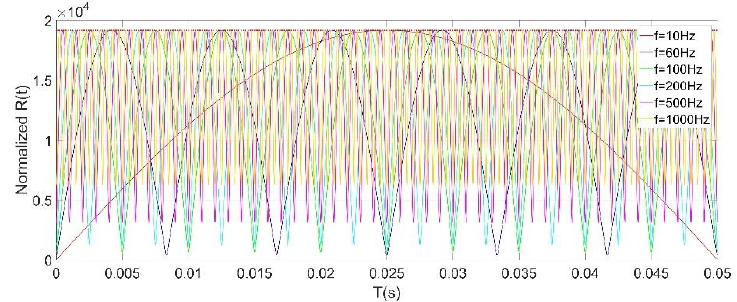
Figure 9. Normalized simulation results of R i ( t ) at different measured field frequencies, ω s = 2 π · 3050 rad / s, ϕ i = 0.